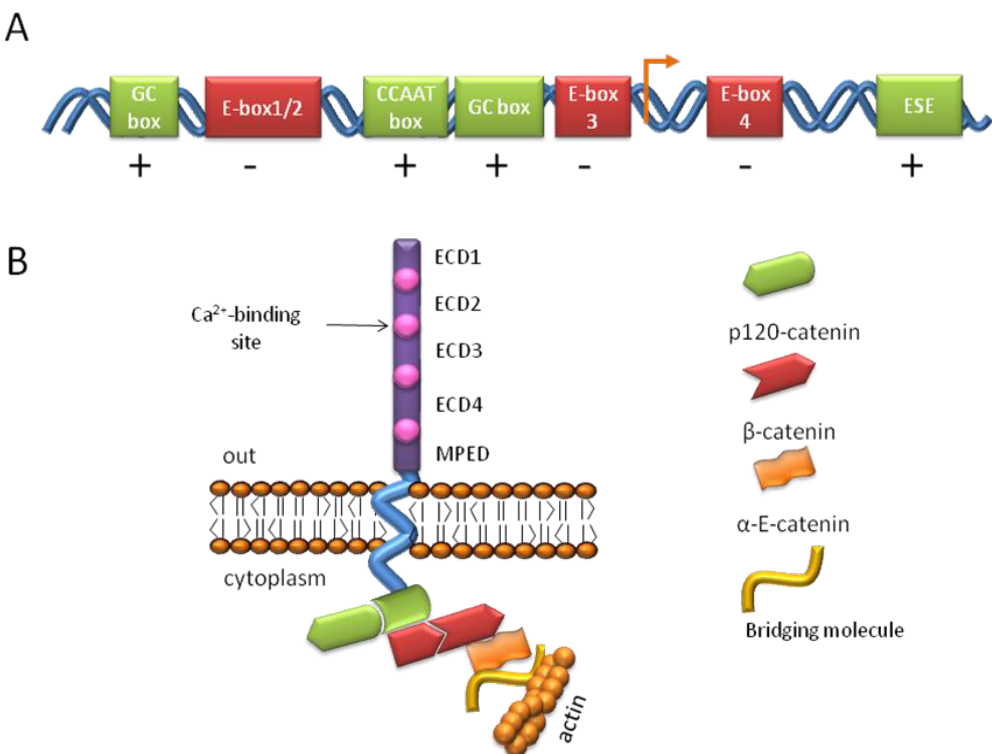
Figure 4. Diagrammatic representation of the E-cadherin promoter and protein. ( A ) Promoter region of the Cdh1 gene encoding for E-cadherin. The figure shows both positive (GC boxes and CCAAT boxes) and negative (E boxes) regulatory elements. Note the location of E-box 4 after the transcription initiation site (orange arrow) and the presence of an epithelial specific enhancer (ESE) located within an unusually large intron 2. ( B ) Diagrammatic representation of the E-cadherin/catenin complex anchored to the actin cytoskeleton. The extracellular region of E-cadherin contains four extracellular cadherin domains (ECD) and an atypical membrane proximal domain (MPED). Calcium ion-binding sites are located between ECDs and are necessary for cell adhesion mediation. β-Catenin and p120-catenin bind specific regions within the cytoplasmic domain of E-cadherin. α-E-catenin might directly anchor the complex to the actin cytoskeleton by binding with F-actin and β-catenin or indirectly through an additional bridging molecule (e.g., EPLIN). ECD = extracellular cadherin domain; MPED = Membrane Proximal Extracellular